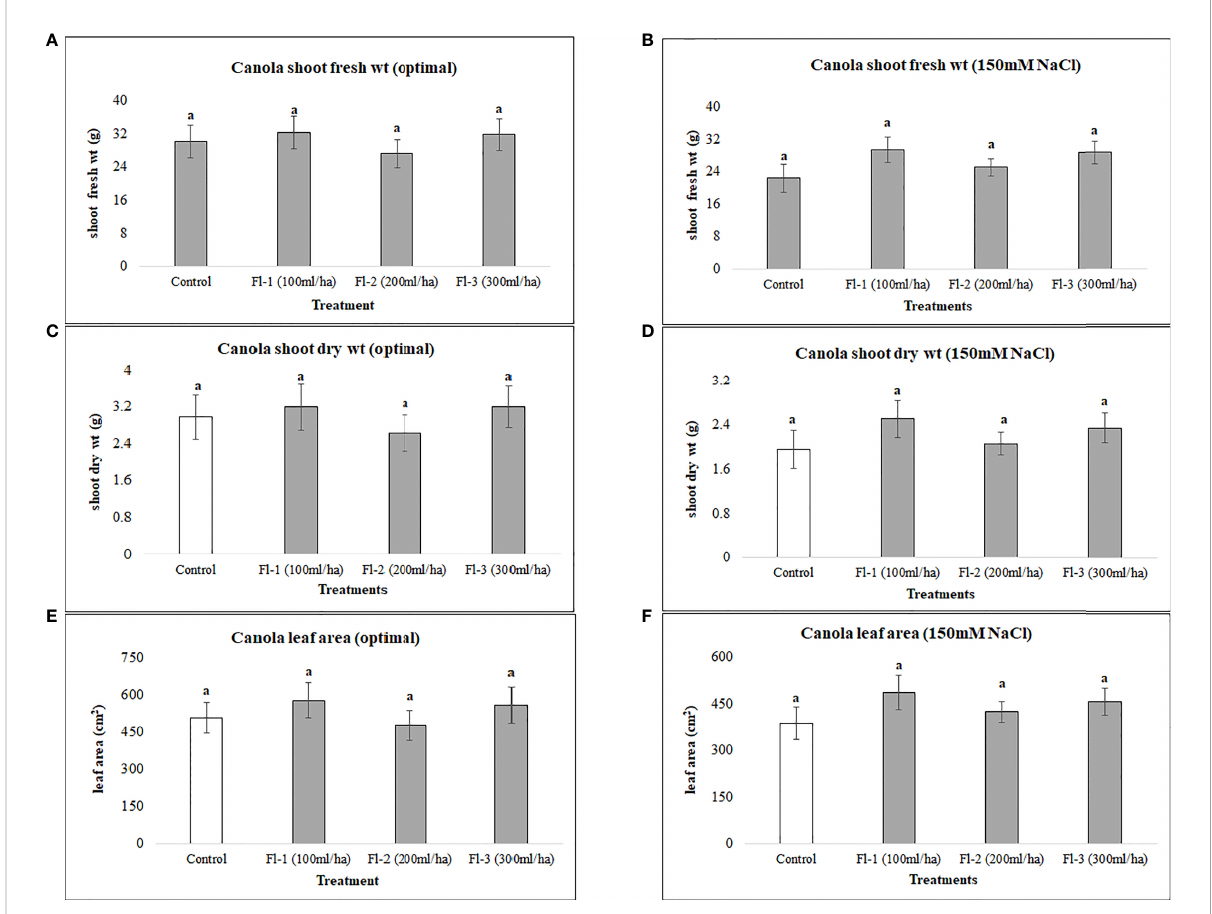
FIGURE 5 Canola above ground biomass affected by fl avonoids (A) shoot fresh wt - optimal (B) shoot fresh wt – 150 mM NaCl (C) shoot dry wt - optimal (D) shoot dry wt – 150 mM NaCl (E) leaf area - optimal (F) leaf area – 150 mM. The data represents the mean values of 8 replications (n=8) ± standard error. Different letters indicate values determined by Tukey ’ s multiple mean comparison to be signi fi cantly different (p< 0.05) from each